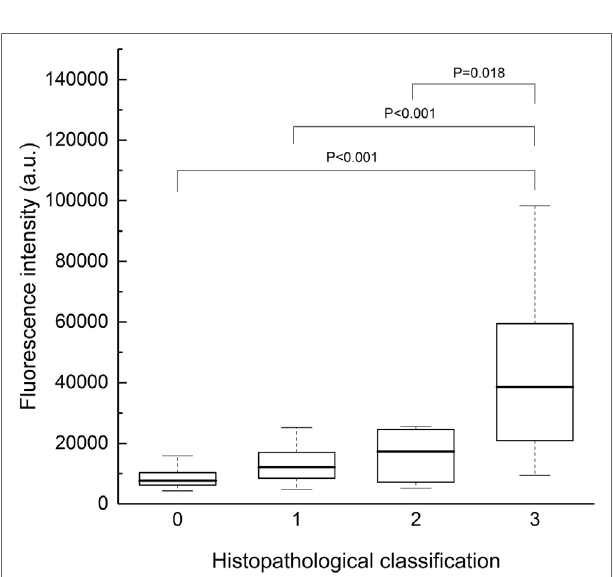
FigUre 6 | Fluorescence intensity of all samples, plotted according to histopathological classification (0–3). Class 3 samples exhibited markedly strong fluorescence, and a significant increasing trend with classification was observed (Jonckheere–Terpstra test, P < 0.001). The Steel–Dwass test revealed statistically significant differences between class 0 and 3 ( P < 0.001), class 1 and 3 ( P < 0.001), and class 2 and 3 ( P = 0.018); the other comparisons were not significant. Each box indicated the interquartile range, and the median was shown with a bold line. The ends of the whiskers represented the 10th and the 90th percentile. a.u., arbitrary units; CE, contrast-enhanced; NCE, non-contrast-enhanced.